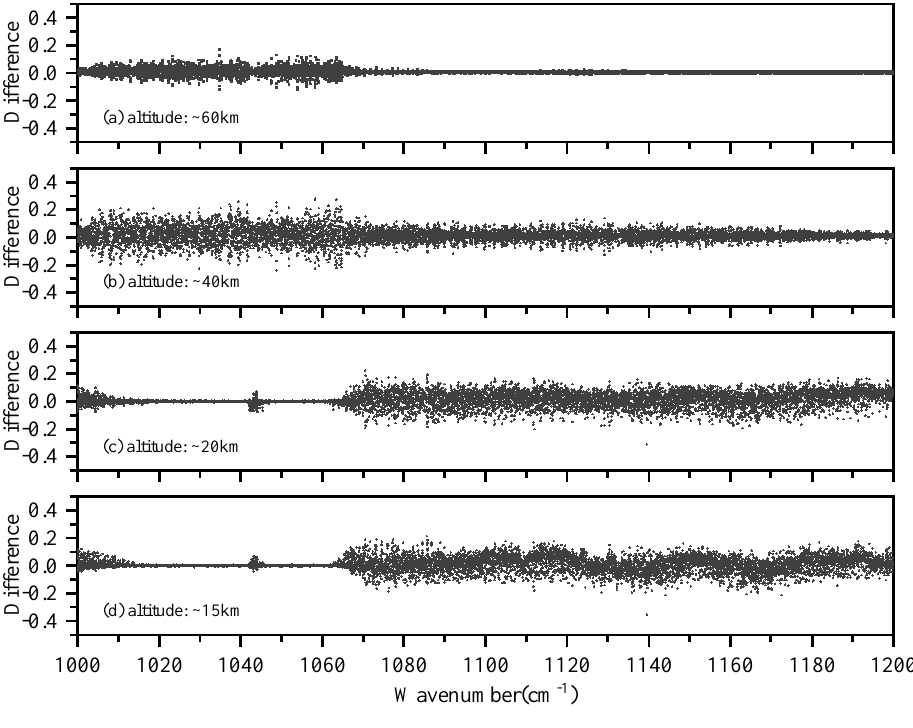
Figure A2. The transmittance differences between AIUS measurements and simulations in 1000–1200 cm − 1 .